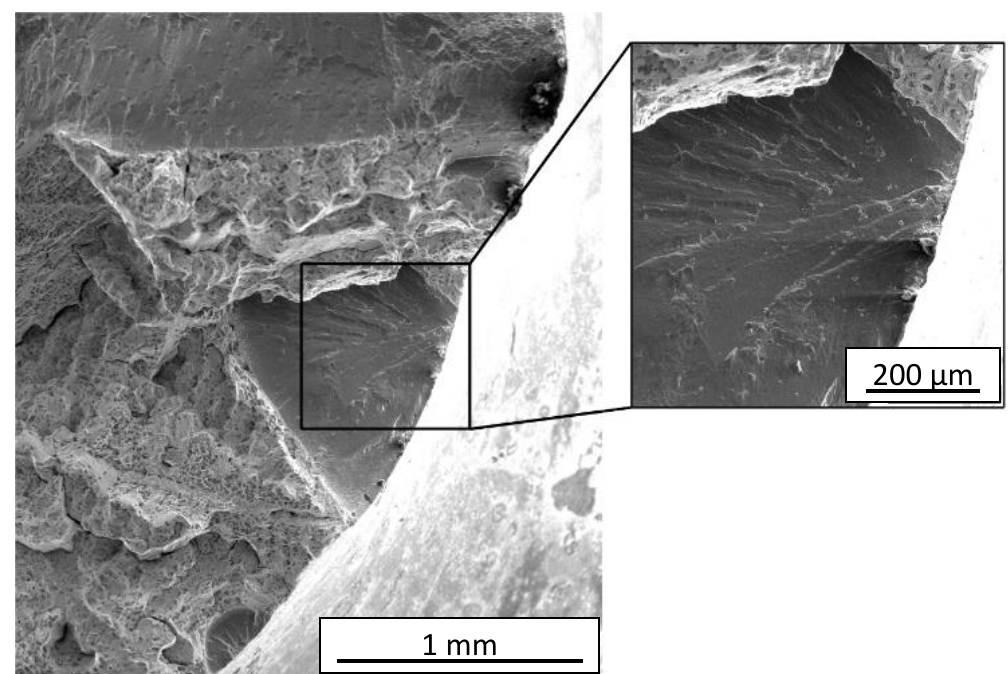
Figure 7. Fatigue and residual fracture surface of a notched specimen.